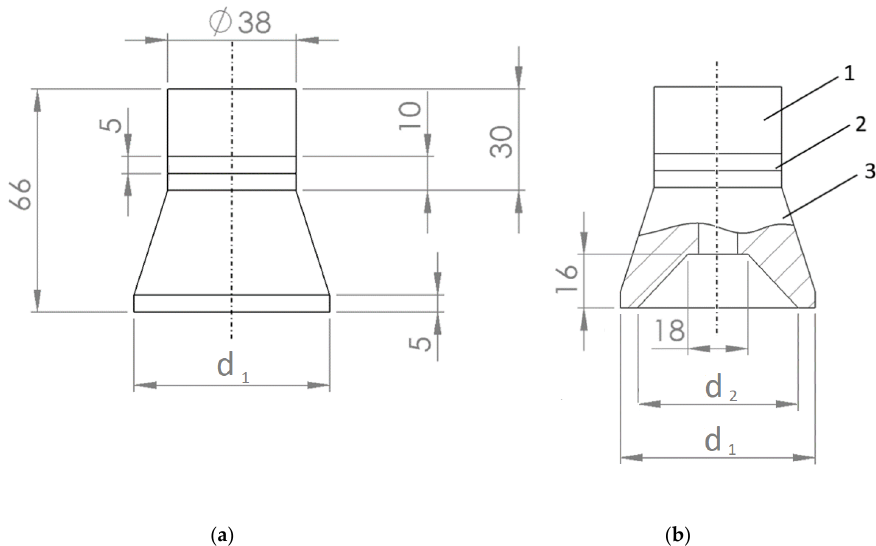
Figure 1. Geometric dimensions of the piezo transducer in mm with flat surface ( a ) and ring-shaped surface ( b ) of the front mass 3: 1—back mass; 2—two ring-shaped piezoelectric elements; 3—front mass.